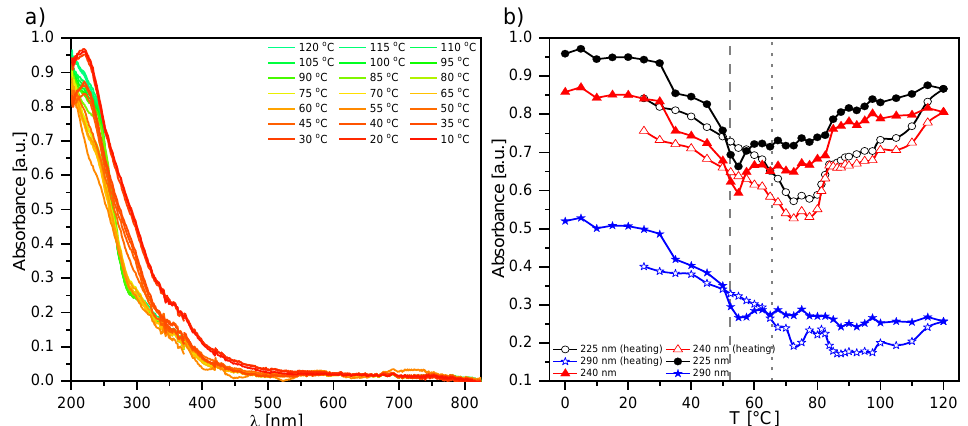
Figure 6. Solid state UV-vis absorption spectra of Composite 6 ( γ -Fe 2 O 3 , 0.3 wt % + oleic acid) at several chosen temperatures in the 200–850 nm range ( a ), and the influence of heating and cooling on the absorbance at 225, 240, and 290 nm ( b ). The vertical dashed and dotted lines represent the SmA* – SmC* and N* – SmA* phase transition temperatures (during cooling), respectively.